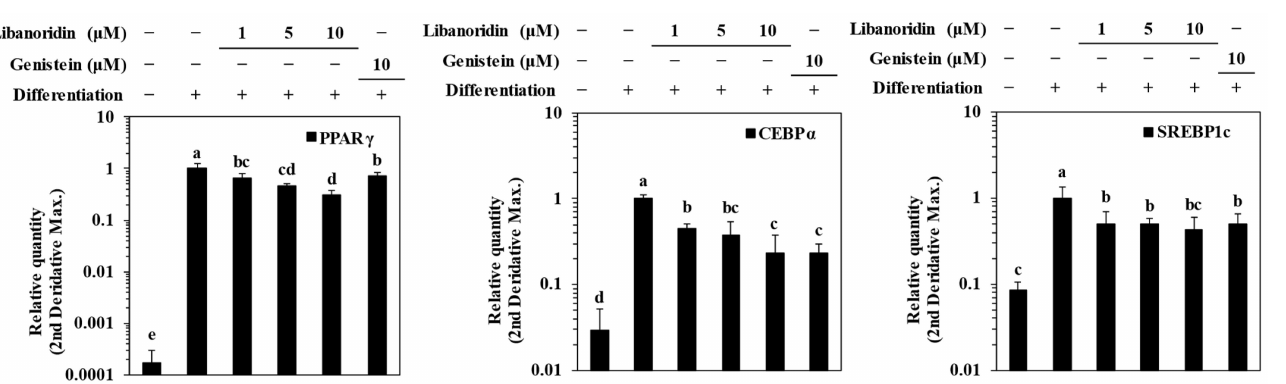
Figure 2. Effect of libanoridin on the mRNA expression of adipogenic transcription factors: PPAR γ , C/EBP α , and SREBP1c. Analysis of the expression levels was carried out via RT-qPCR on adipo- induced hBM-MSCs at day 7 of differentiation. Values are means ± SD ( n = 3). a–e Bars with identical letters indicate no statistical significance ( p < 0.05), while different letters indicate otherwise.